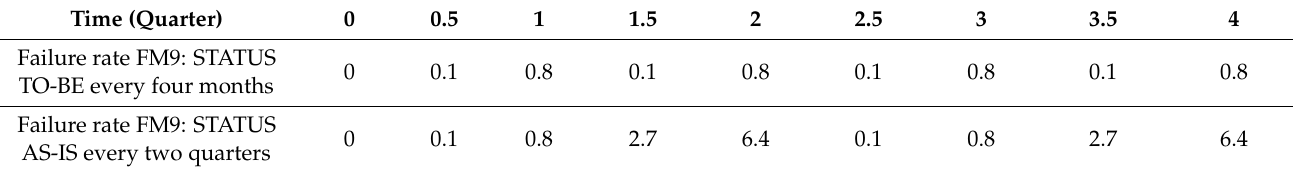
Figure 12. The FM9 failure rate with maintenance every four months. AS-IS state: guide adjustment rate every two quarters. TO-BE state: guide adjustment rate every four months. Table 3. FM9 Failure rate.